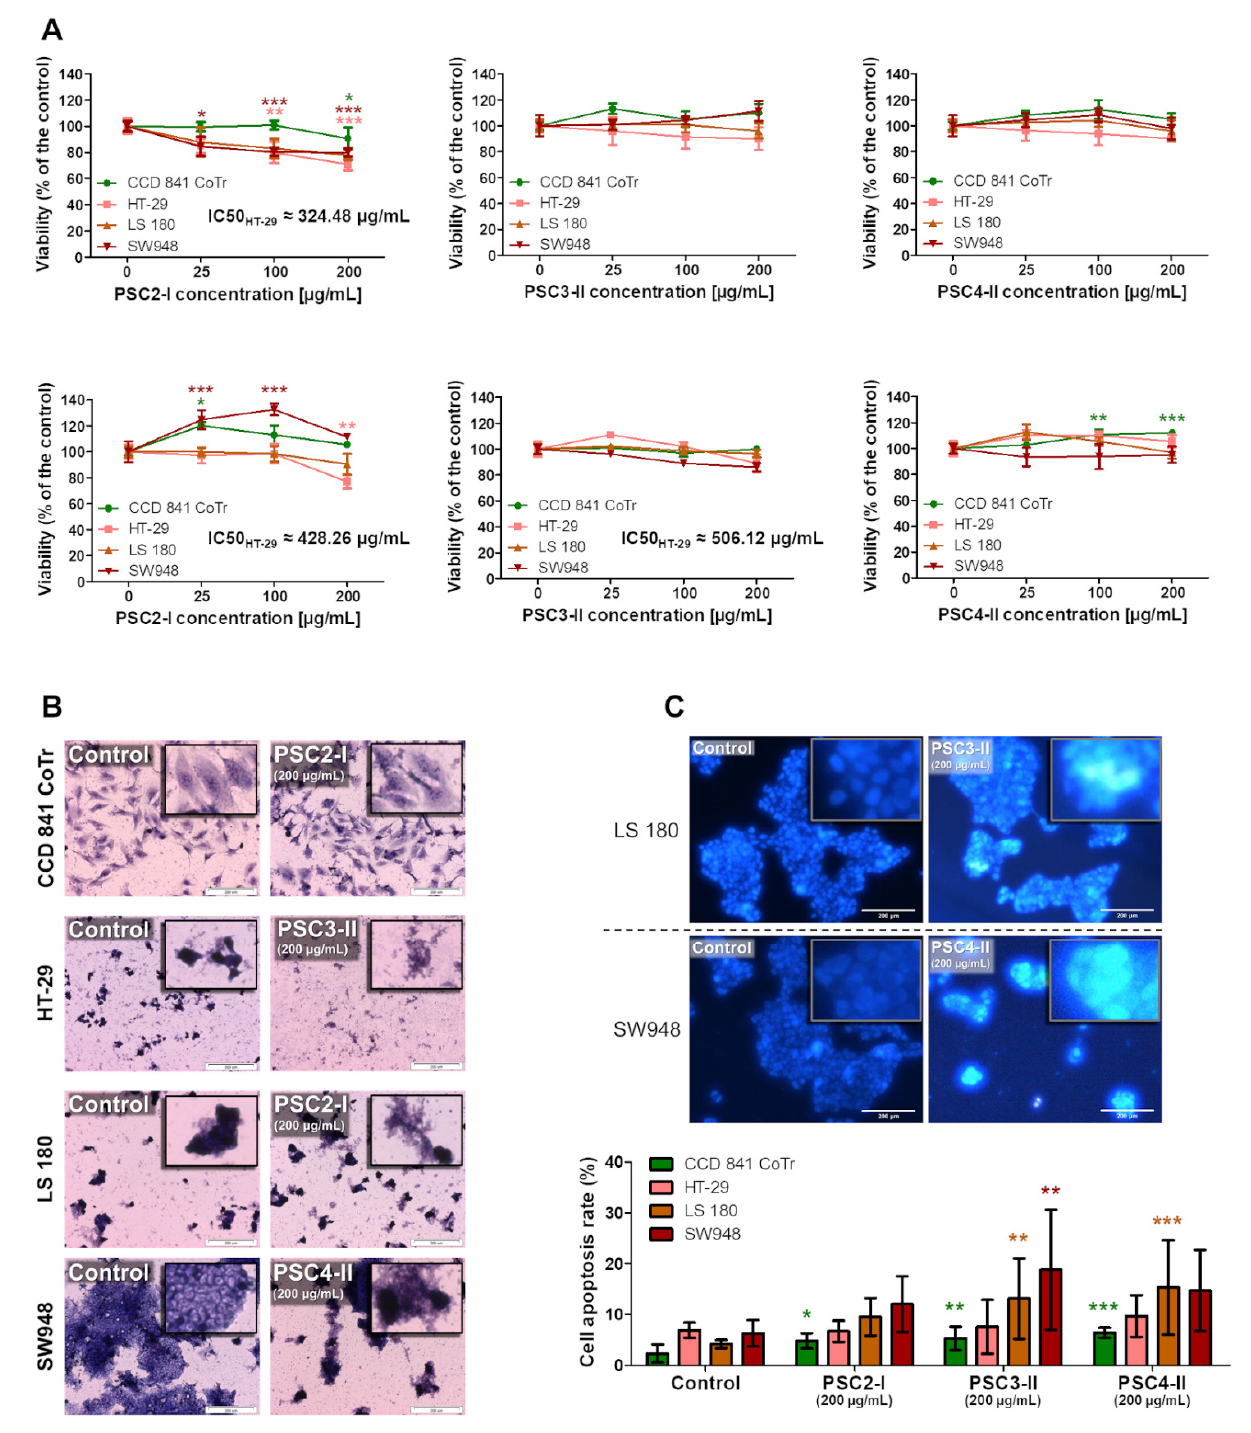
Figure 3. Anti-cancer effect of the PSC2-I, PSC3-II, and PSC4-II extracts on CCD 841 CoTr, HT-29, LS 180, and SW948 cells: ( A ) effect on cell viability (upper panel: NR method, PSC2-I, PSC3-II, and PSC4-II in the row, respectively; bottom panel: MTT method, PSC2-I, PSC3-II, and PSC4-II in the row, respectively); ( B ) effect of the extracts (at 200 µ g/mL) on cell morphology-May-Grünwald-Giemsa staining (for all images, see Supplementary Materials Figure S1) (the measurement bars indicate 200 µ m); ( C ) effect of the extracts (at 200 µ g/mL) on the apoptotic rate (the measurement bars indicate 200 µ m) (for all images, see Supplementary Materials Figure S2); * p < 0,05, ** p < 0,01, *** p < 0,005, one-way ANOVA, Dunnett’s